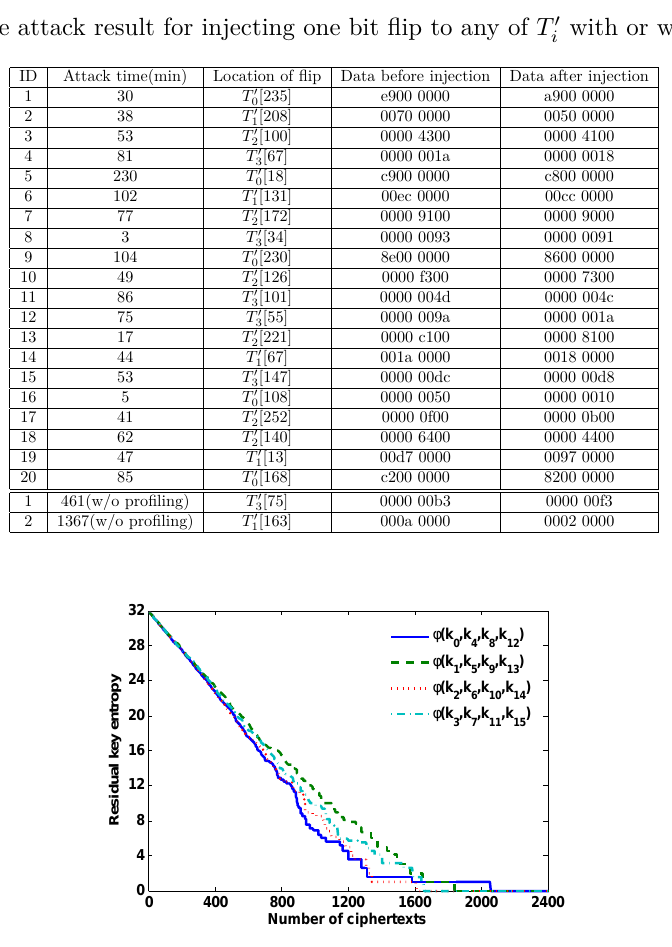
Figure 12: The residual key entropy v.s. the sample size. The PFA attack is conducted on Libgcrypt 1.6.3 with